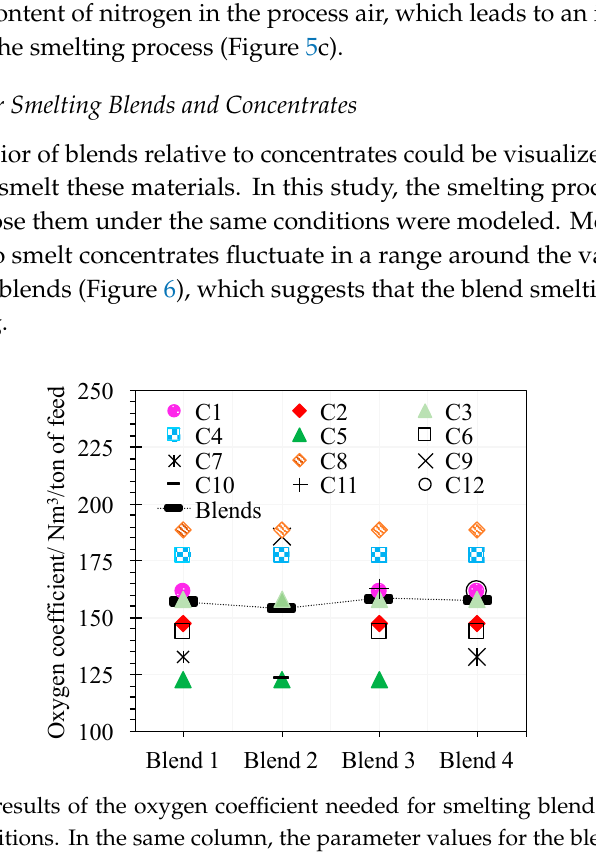
Figure 5. Oxygen enrichment (OE) estimated for increments of some parameters: ( a ) Increment of 1% of silica in the slag composition, ( b ) increment of 1% of recycled dust in feed, and ( c ) increment of 1% of slag converter in the feed.